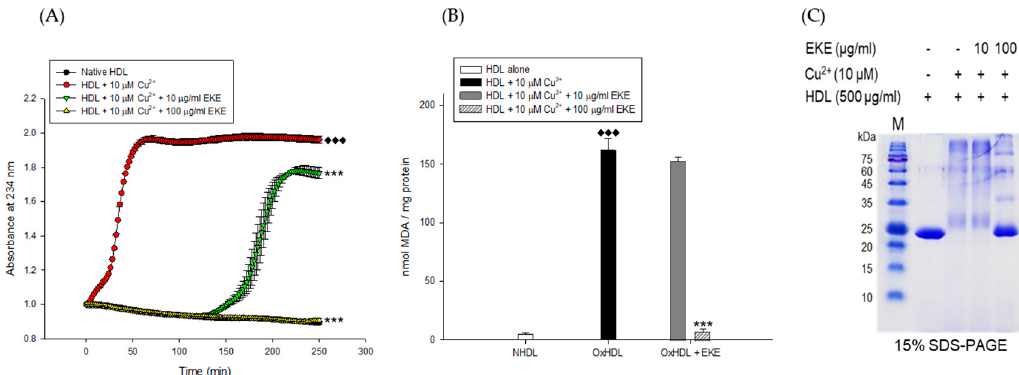
Figure 1. Chemical structures of compounds 1 – 8 ; ( 1 ) anhydroicaritin 3- O -rhamnoside, ( 2 ) β - anhydroicaritin, ( 3 ) epimedin A, ( 4 ) epimedin B, ( 5 ) epimedin C, ( 6 ) epimedoside A, ( 7 ) icariin, and ( 8 ) des- O -methyl- β -anhydroicaritin.